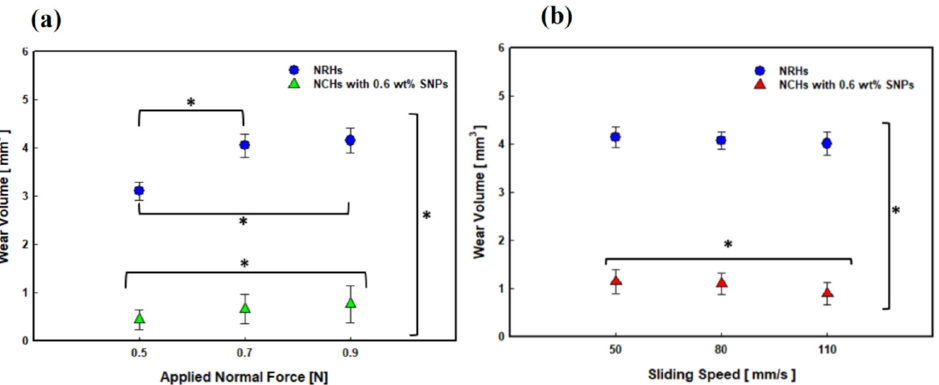
Figure 8. Wear volume of NRHs and NCHs samples at different ( a ) loads and ( b ) sliding speeds (n = 3 ± SD). All tests were performed in lubricated contact. * Statistical significance analyses were conducted by ANOVA and post hoc Tukey test ( p <